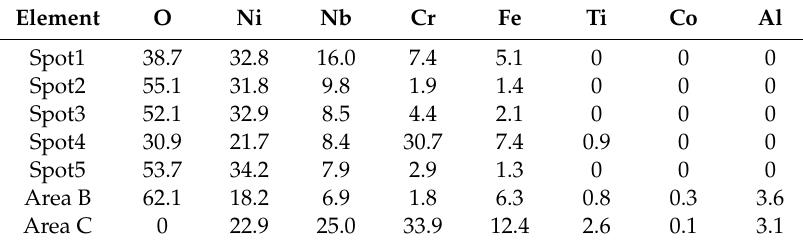
Table 3. EDS’s results of the coating at different positions in Figure 11a (%). Element